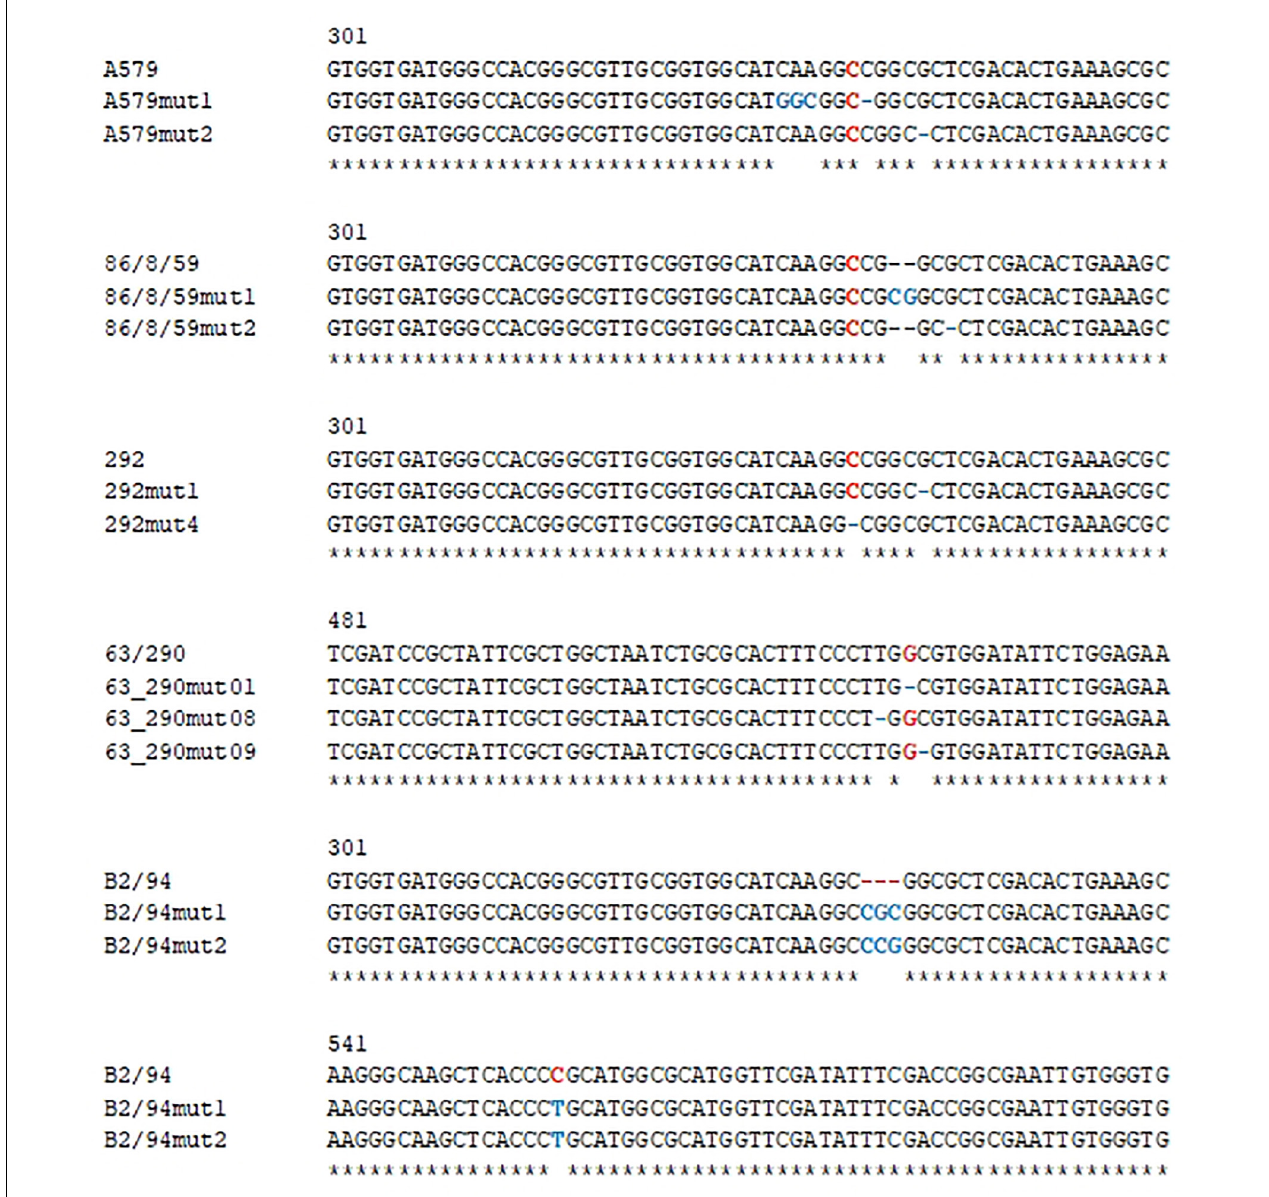
FIGURE 2 | Nucleotide changes in CA II from selected CO 2 -independent mutants of different Brucella strains. Partial sequence of the regions where the original CO 2 -dependent strains had the mutations that caused the defective phenotype (shown in red), and the changes observed after selection and sequencing of different spontaneous CO 2 -independent mutants (shown in